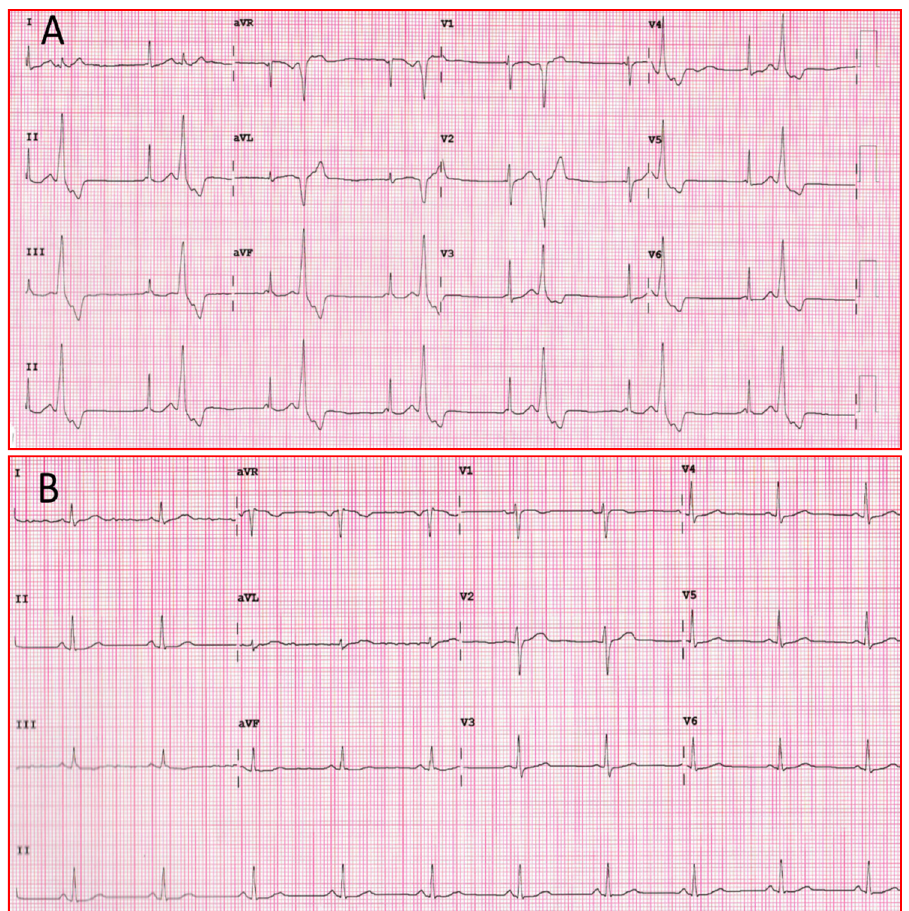
Figure 3. ( A ) Twelve-lead ECG of patient with ventricular bigeminism. ( B ) Twelve-lead ECG of the same patient one hour after taking a flecainide tablet. ECG: electrocardiogram.